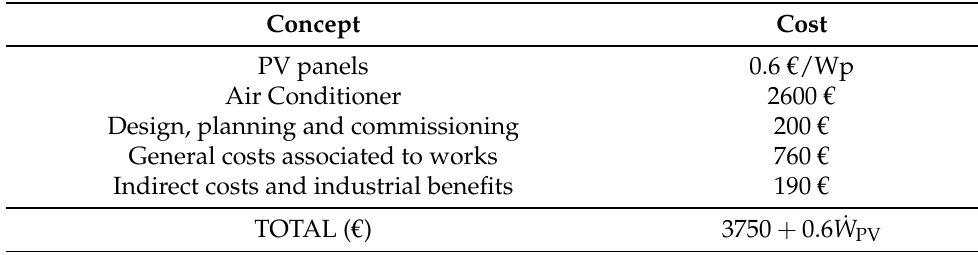
Table 4. Investment costs considered in the